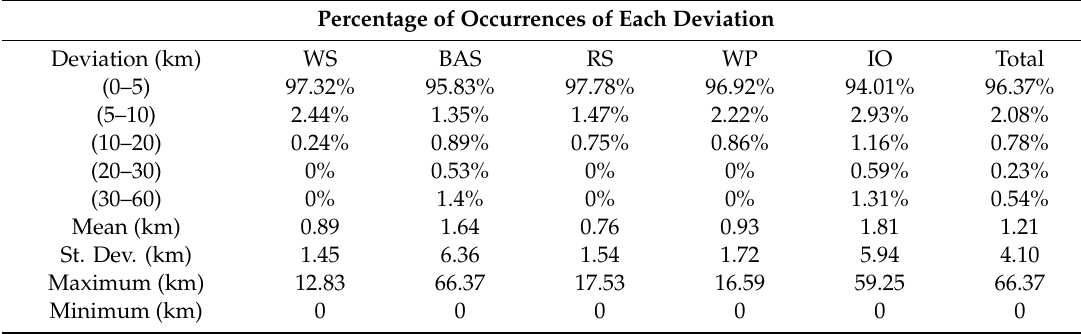
Table 2. Percentage of deviation between the coastline products from the present method in 2005 and the MOA 2004 data set for the five sectors (in km).